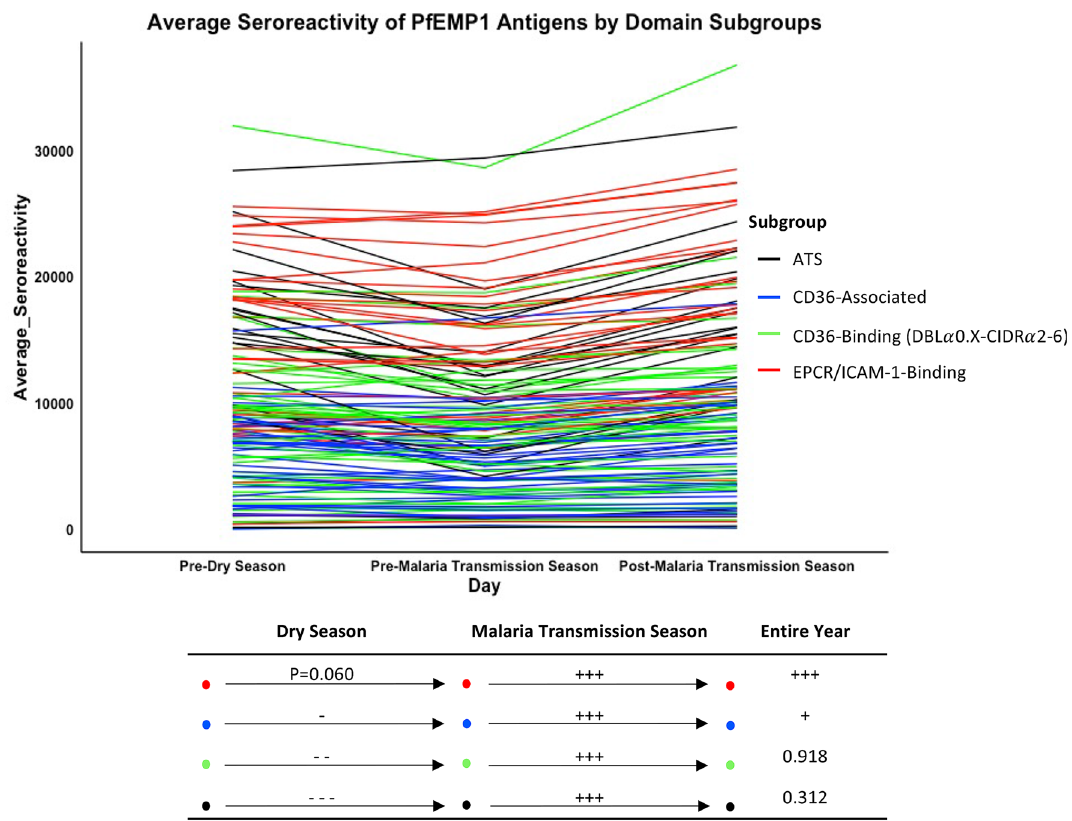
Figure 4. Mean seroreactivity trajectories for individual PfEMP1 fragments across three time points across the year. Individual lines are colored by PfEMP1 subgroup and represent adult mean seroreactivity to the PfEMP1 fragment at three time points: pre-dry season, pre-malaria transmission season, and post-malaria transmission season. The diagram below depicts changes in mean seroreactivity to four subgroups across the dry season (left), malaria transmission season (center), and entire year (right). ‘+++’ and ‘−−−’ indicate P < 0.001, ‘++’ and ‘− −’ indicate P < 0.01, and ‘+’ and ‘−’ indicate P < 0.05 in the Wilcoxon matched-pairs signed-rank test. “CD36- associated” refers to a PfEMP1 fragment downstream from the CIDR α domain of a known CD36-Binding 3D7 PfEMP1. CIDR: cysteine-rich interdomain regions; DBL: Duffy binding-like; ATS: acidic terminal segment; EPCR: Endothelial protein C receptor; ICAM-1: Intercellular adhesion